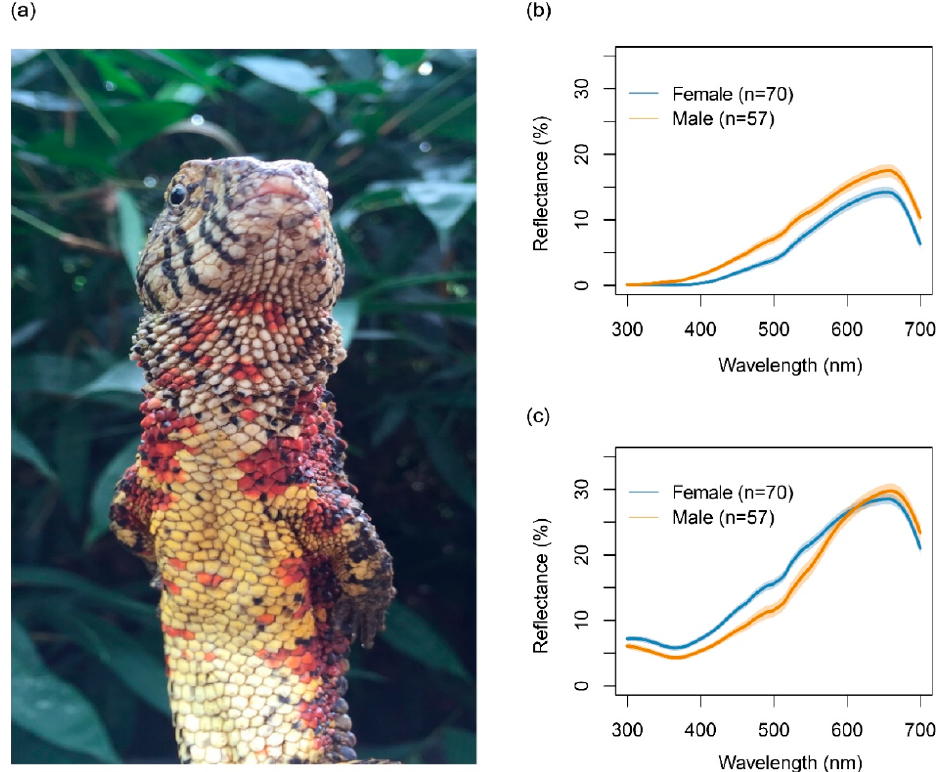
Figure 1. ( a ) A male crocodile lizard ( Shinisaurus crocodilurus ) with red colour patches on the throat and venter. ( b ) Spectral reflectance curve for the throat by sex. ( c ) Spectral reflectance curve for the venter by sex.